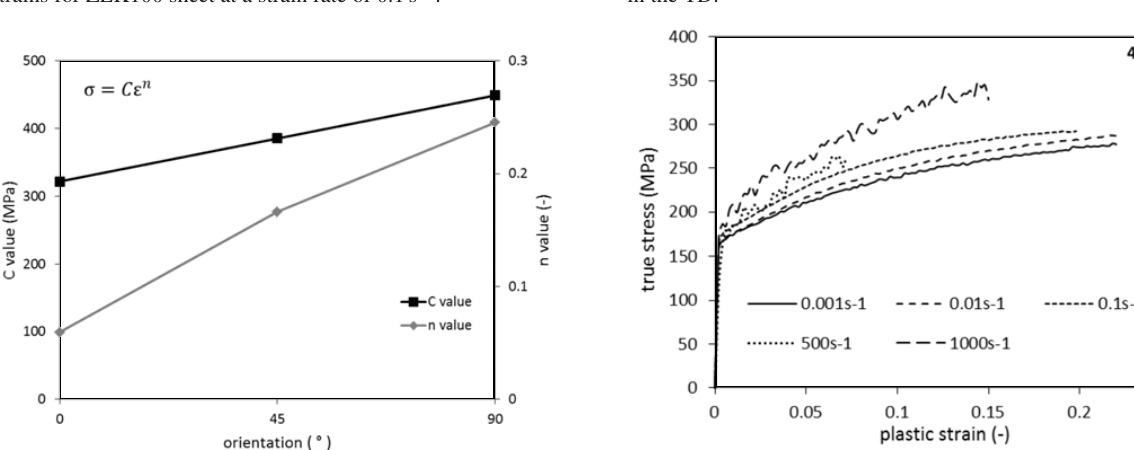
Fig. 12. E ff ect of strain rate on the flow curves of ZEK100 sheet in the TD.